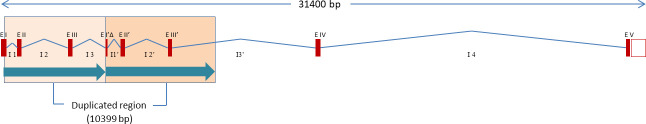
Schematic representation of dmrt1 gene in the genome of Solea senegalensis.The gene is 31,4 kb long. It shows seven exons (with EII and EIII duplicated as EII’ and EIII’, EI’Δ is a partial and non-functional exon) and seven introns. The exons are indicated by red boxes and introns by blue lines. Empty boxes denote the 3’UTR region. The full duplicated region is 10,4 kb long. The region begins from the end of Exon I to the end of intron 3, and is next duplicated until part of intron 3’. The first region (light pink box) comprises end of Exon I–Intron 1 –Exon II- Intron 2—Exon III–Intron 3. The duplicated region comprises Exon I’Δ–Intron I’–Exon 2’- Intron II’—Exon III’–part of Intron 3’.